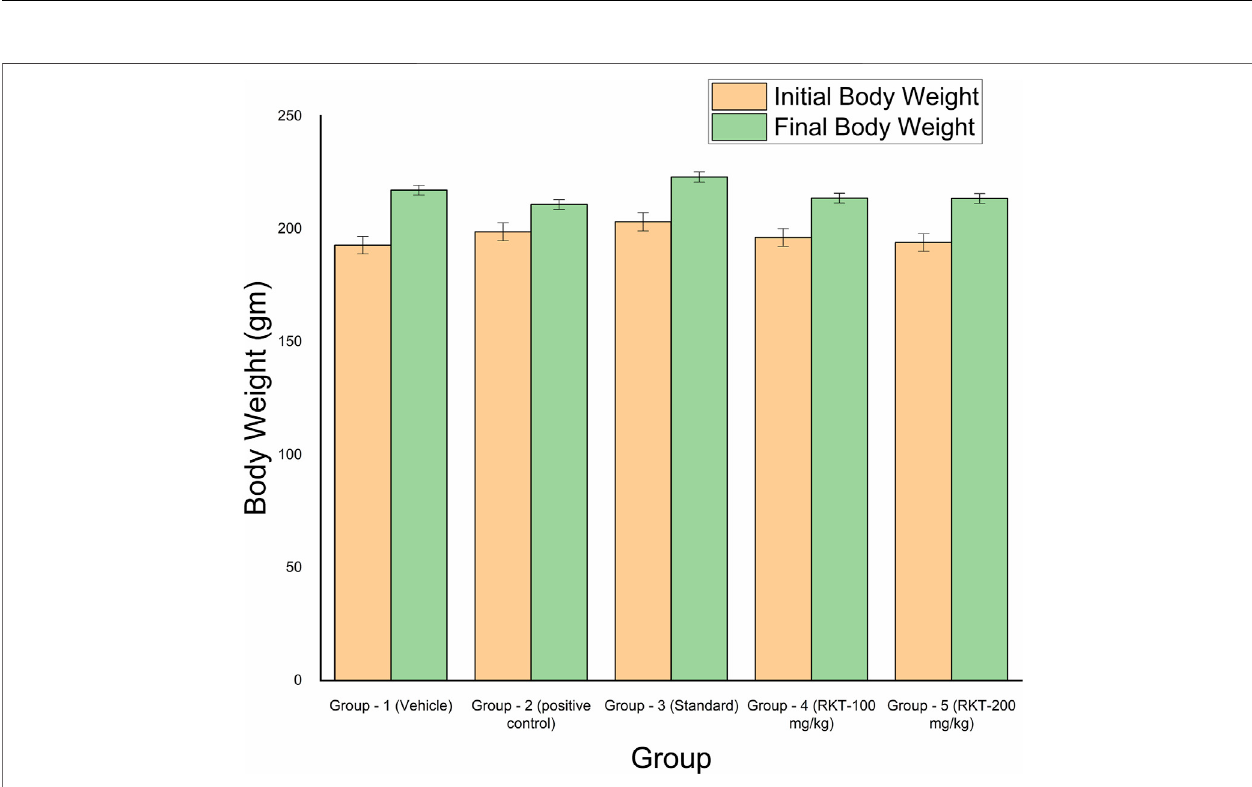
FIGURE 9 | In-vivo anti-arthritic activity (bodyweight in gm).